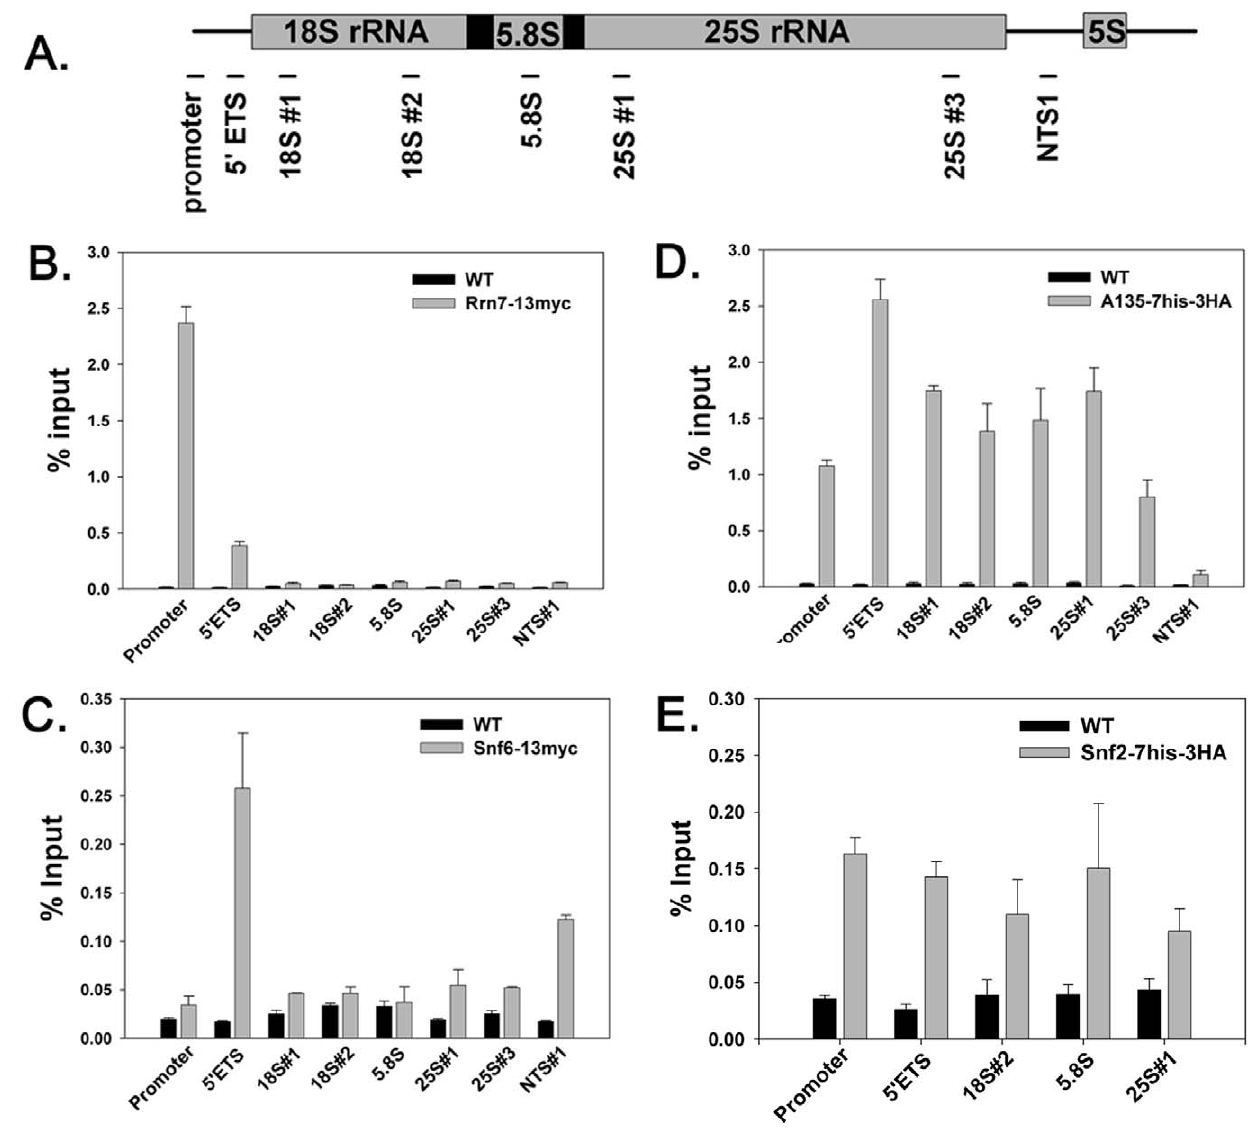
Figure 2. SWI/SNF associates with rDNA. Yeast cells were cultured, crosslinked with formaldehyde, lysed, sonicated and immunoprecipitated with anti-Myc 9E10 or anti-HA 12CA5 antibody. (A) Positions of 8 pairs of primers used in real-time PCR analyses are indicated by horizontal bars under the schematic of an rDNA repeat. (B) Positive control [Rrn7-(MYC) 13 (DAS303)] and negative control [WT (NOY396)] ChIP results. Y-axis represents the amount of rDNA immunoprecipitated relative to total rDNA in input samples. (C) Snf6p (DAS649) ChIP signal compared to negative control. (D) A135-(his) 7 -(HA) 3 (DAS477) associates with the promoter and the entire coding region of rDNA. (E) Snf2p (DAS750) associates with the coding region of the rDNA. Data were quantified from at least 2 10-fold dilutions per sample from duplicate cultures. Error= 6 1standard